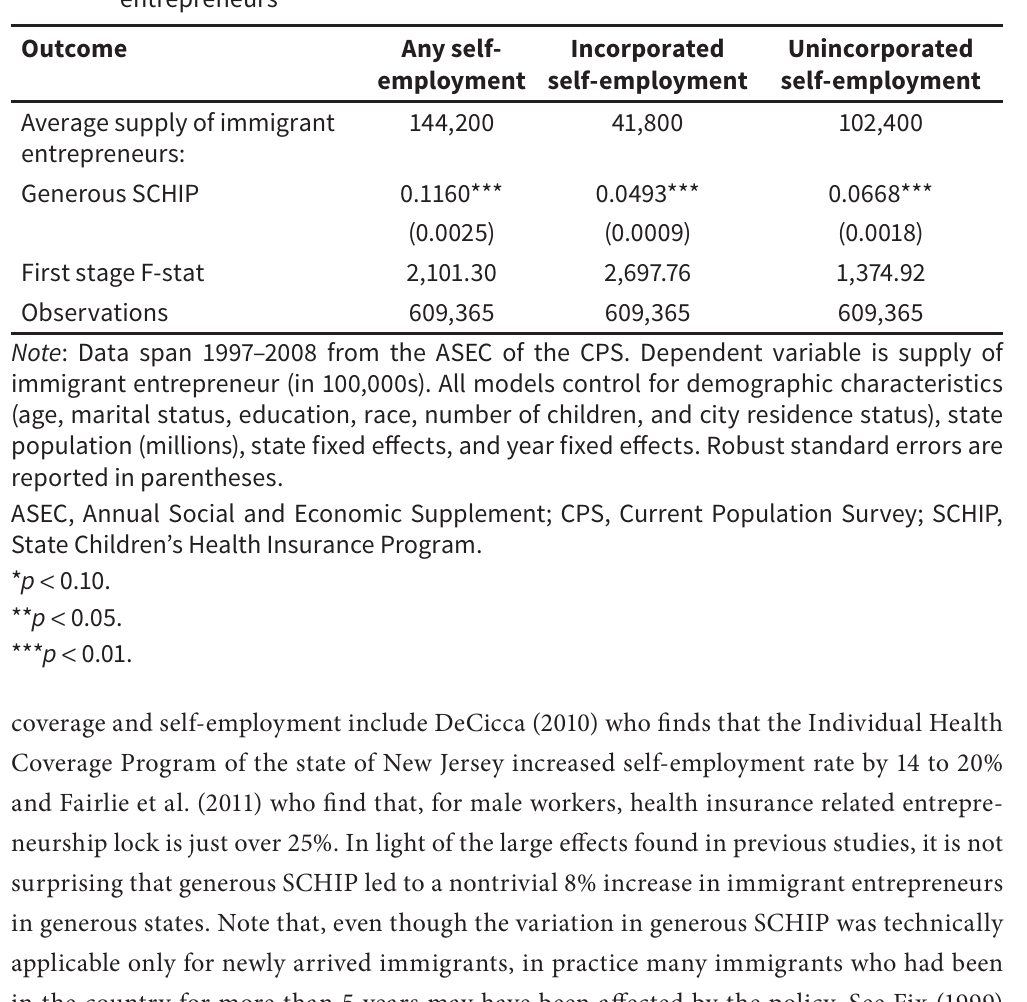
First-stage regressions: impact of generous SCHIP on supply of